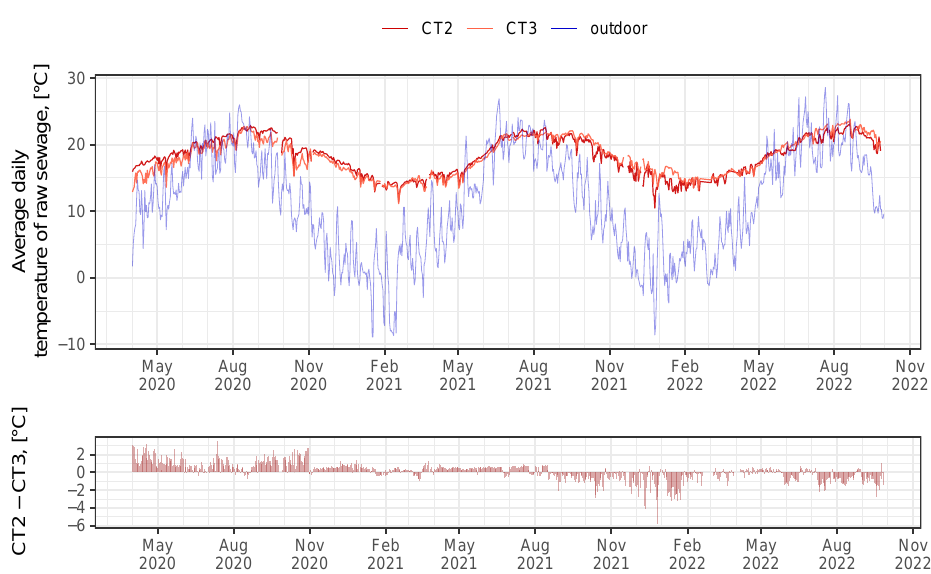
Figure 2. Average daily temperatures of raw sewage in technological lines CT 2 and CT 3.